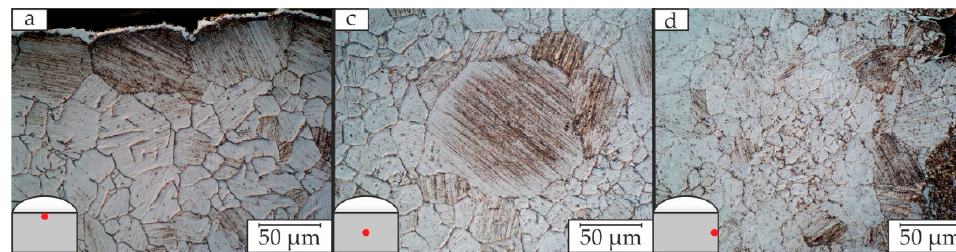
Figure A7. Microstructure in defined positions a, c and d according to Figure 1 (right) of a TNM sample sintered at 1400 °C, with 2 min dwell time and 30 MPa pressure.